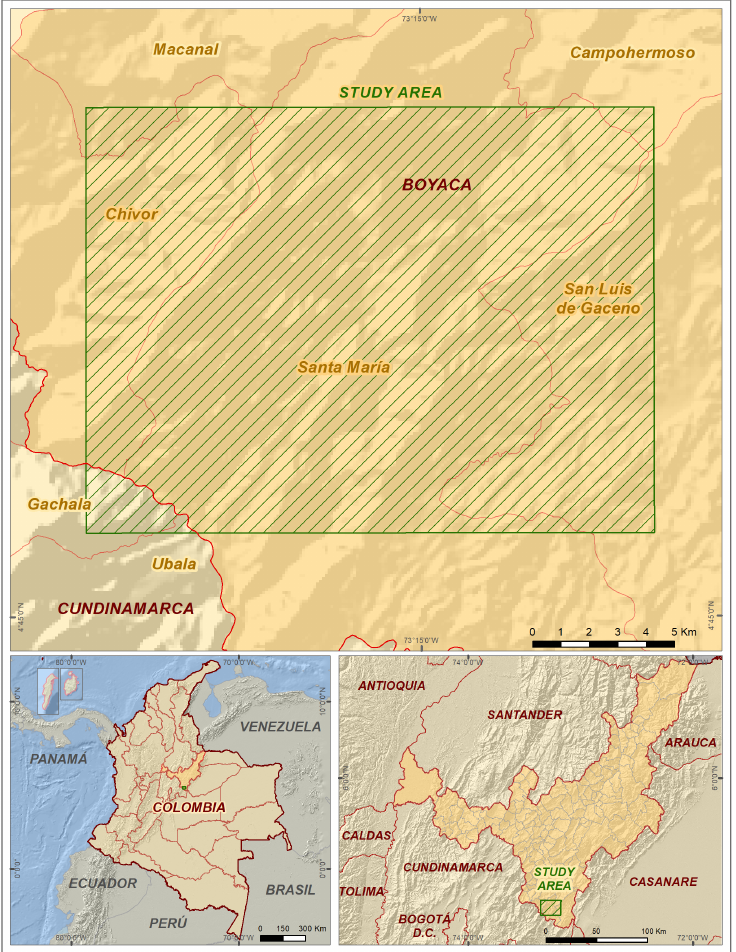
Figure 2. Location of the study area corresponding to the department of Boyacá, Colombia.